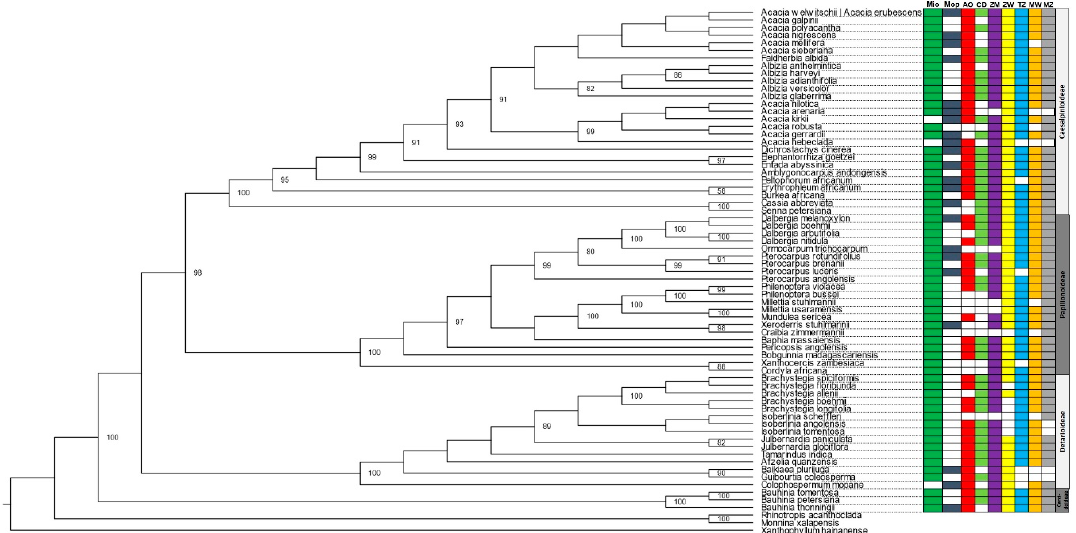
Figure 4. Phylogenetic tree of the Leguminosae tree species from Miombo and Mopane ecosystems. The phylogeny was constructed with three selected genes (ITS + matK + rbcL) and the maximum likelihood (ML) method. Acronyms for the countries/regions: Mio—Miombo; Mop—Mopane; AO—Angola; DRC—Democratic Republic of the Congo; ZM—Zambia; ZW—Zimbabwe; TZ—United Republic of Tanzania; MW—Malawi; MZ—Mozambique.